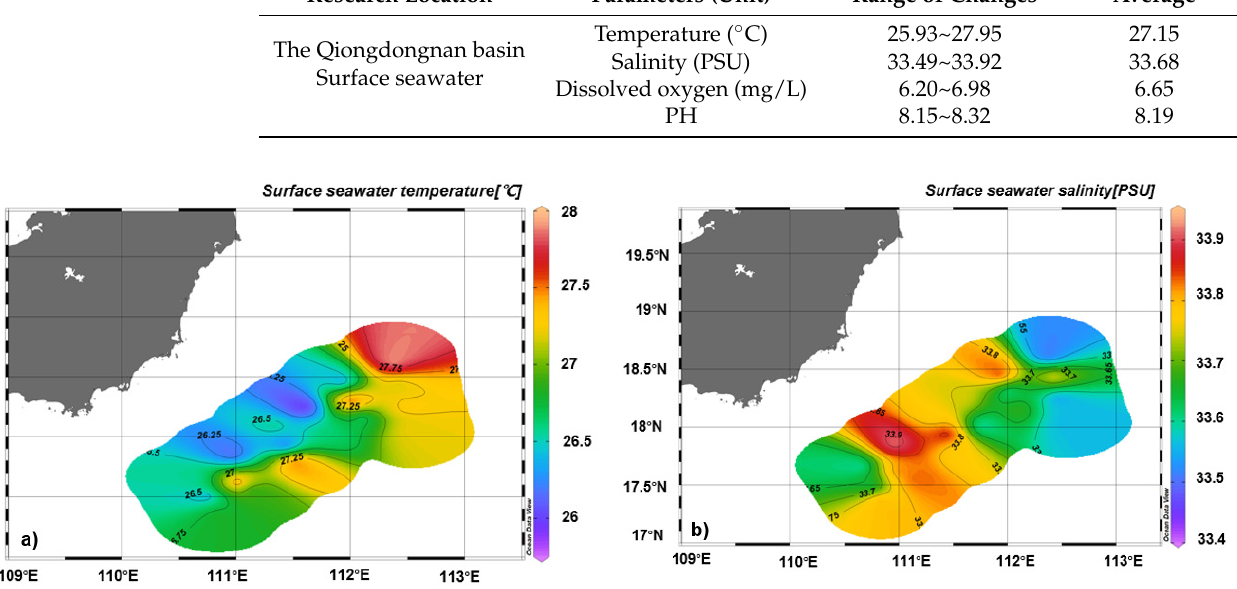
Figure 10. ( a ) Distribution map of surface seawater temperature and ( b ) surface seawater salinity in the Qiongdongnan area in June 2019.